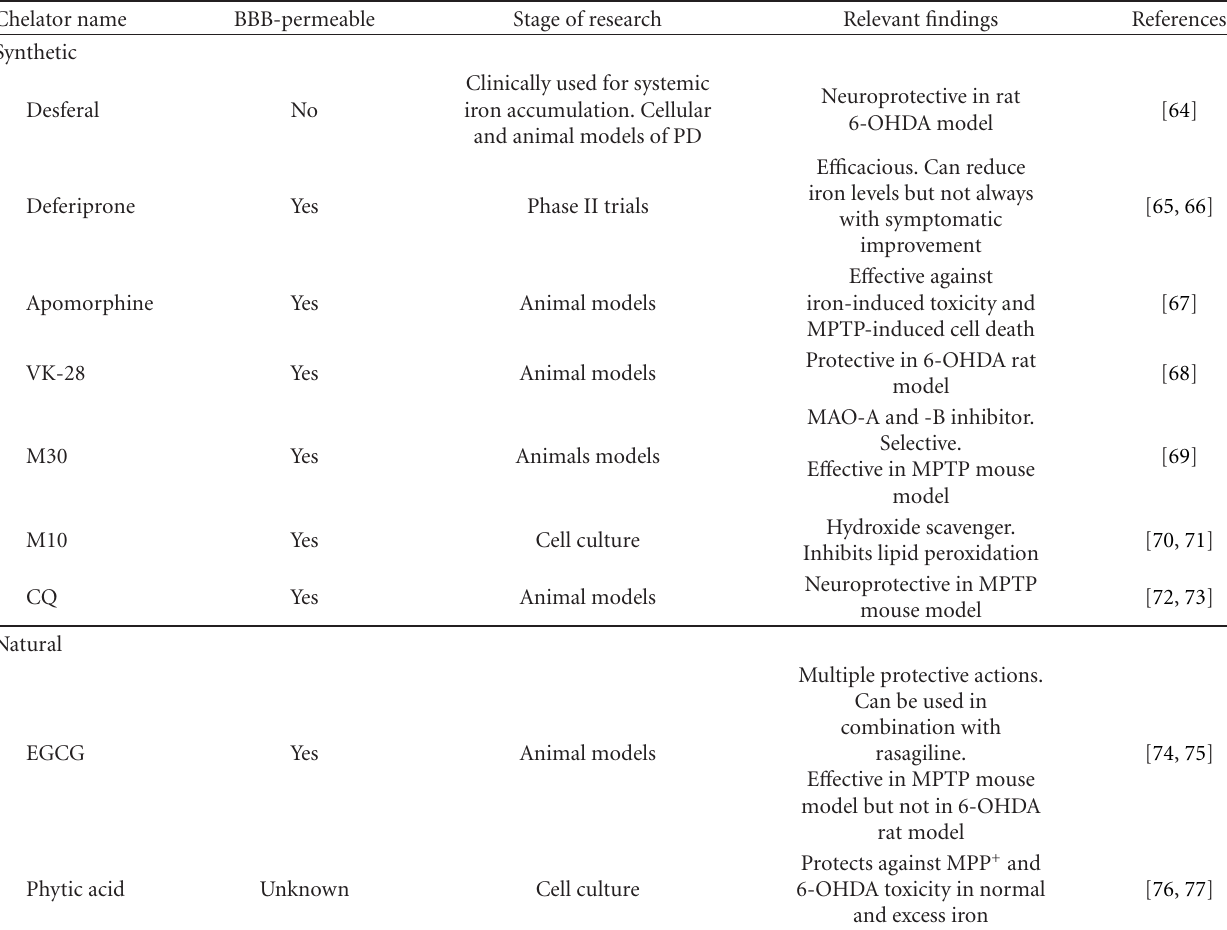
Table 1: Iron chelators in brief. Summary of key information regarding iron chelators currently undergoing research as possible PD